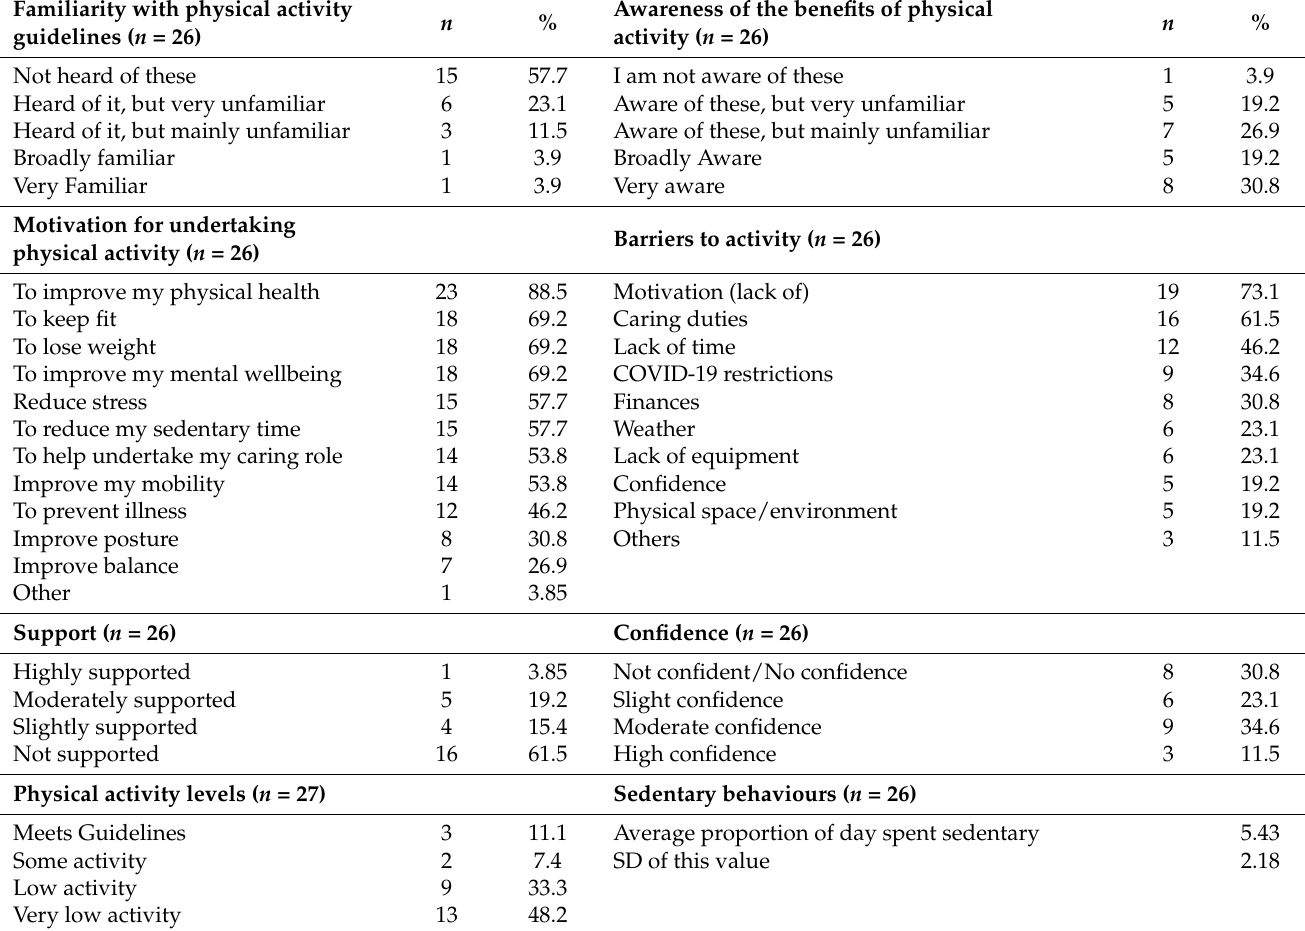
Table 2. Physical activity levels and views of participants at